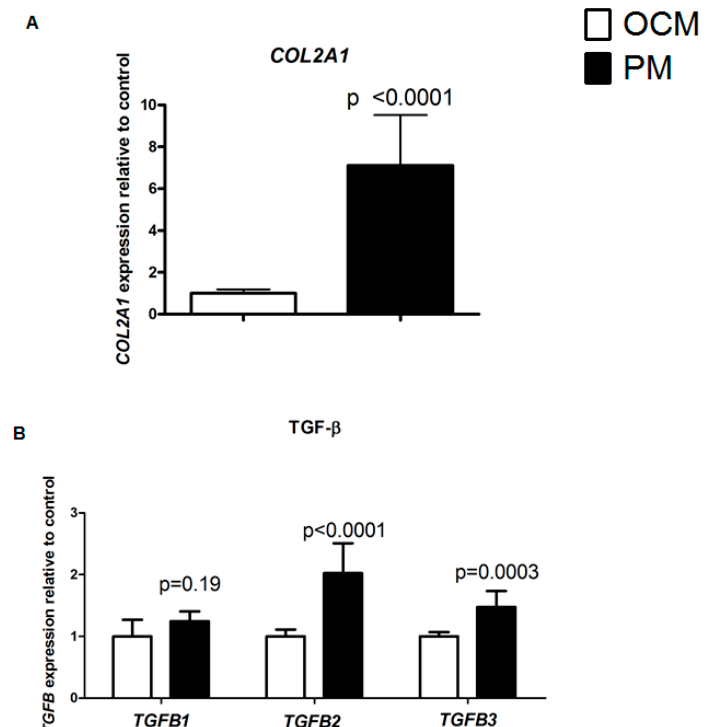
Figure 1. Physosmolarity-induced changes in gene expression of chondrocytes in vitro. Isolating and expanding HACs at PM for 7 days (black bars) significantly increased gene expression of COL2A1 ( A ), as well as TGFB2 and TGFB3 as compared to control (OCM; white bars) ( B ). Gene expression of TGFB1 was not significantly affected ( B ). mRNA levels were determined relatively to control OCM conditions by RT-qPCR (normalized for housekeeper expression) in HACs. Data are from six donors measured in duplicate and presented as the mean ± standard deviation.